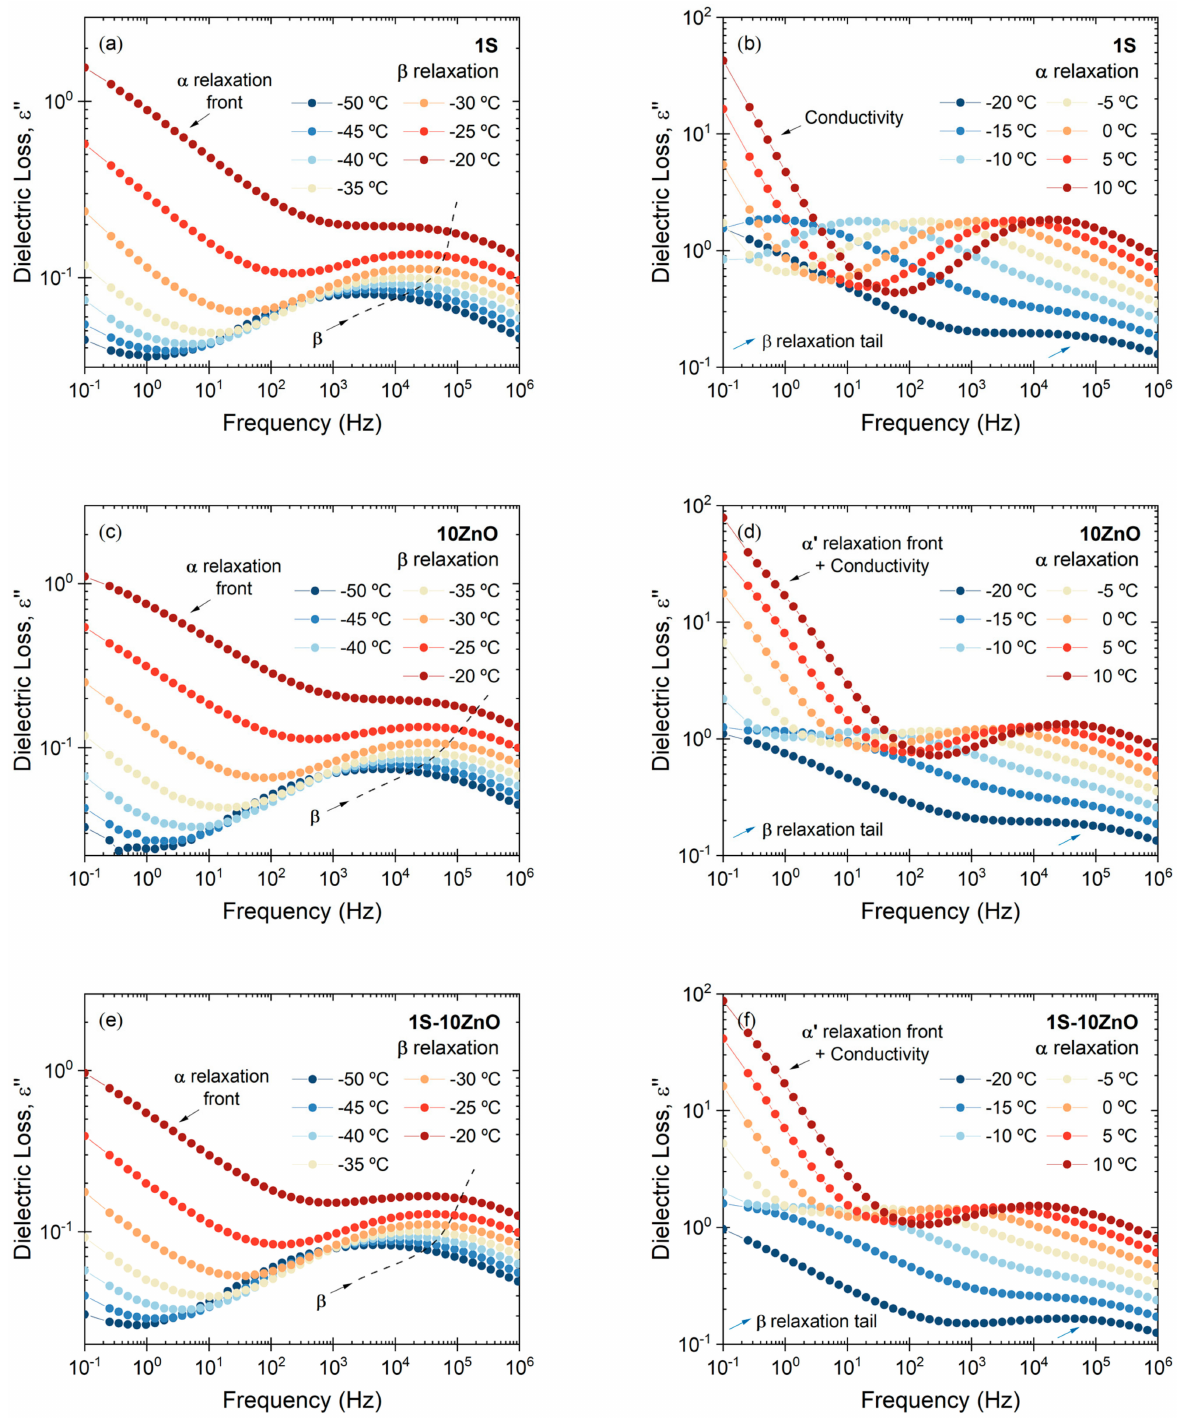
Figure 8. β and α relaxation in ( a , b ) 1S; ( c , d ) 10 ZnO; and ( e , f ) 1S-10